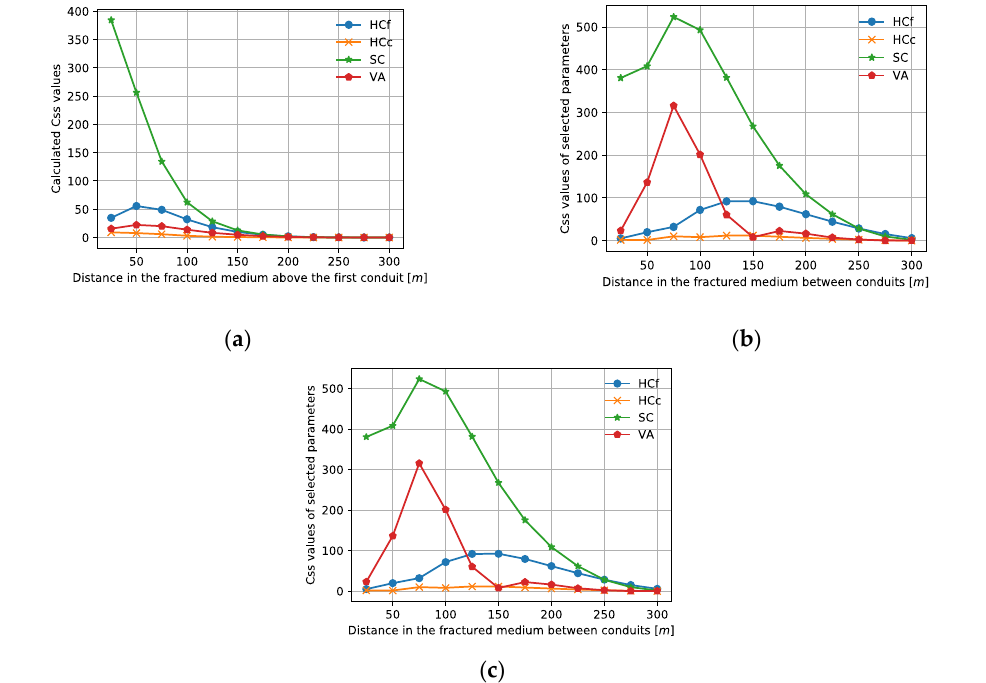
Figure 8. Calculated Css values of selected parameters at different locations in the fractured medium: ( a ) above the first conduit; ( b ) between the two conduits; ( c ) below conduits, and row 25.